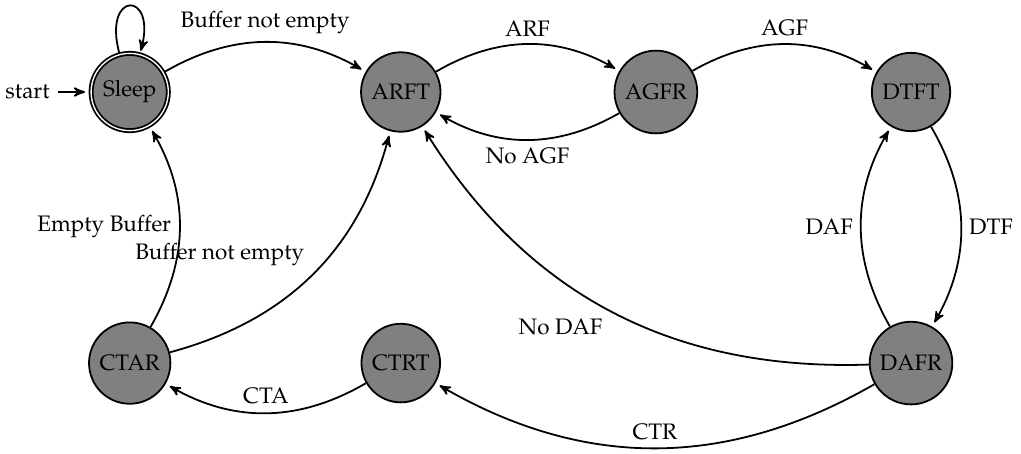
Figure 4. The visible light nodes (VLN) finite state machine in the